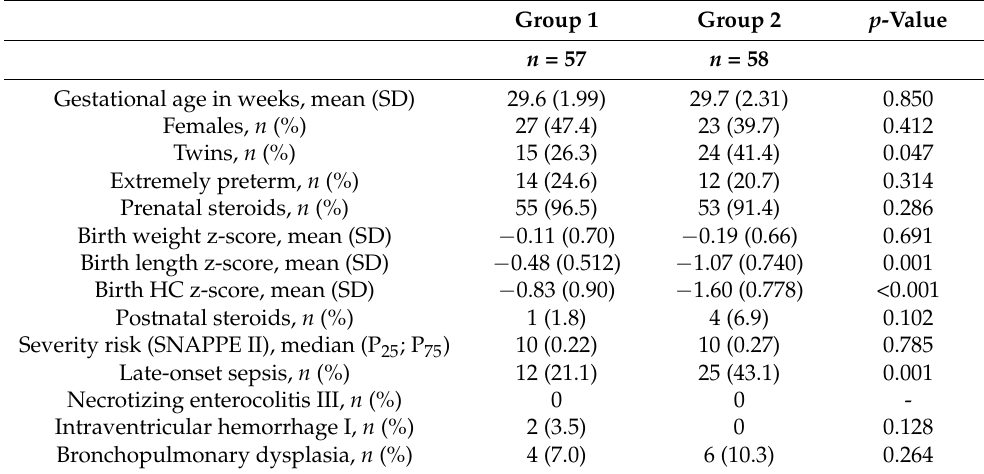
Table 2. The characteristics of infants that completed the exposure period ( n = 115). Group 1—fortified HM based on its assumed macronutrient content. Group 2—fortified HM based on its measured macronutrient